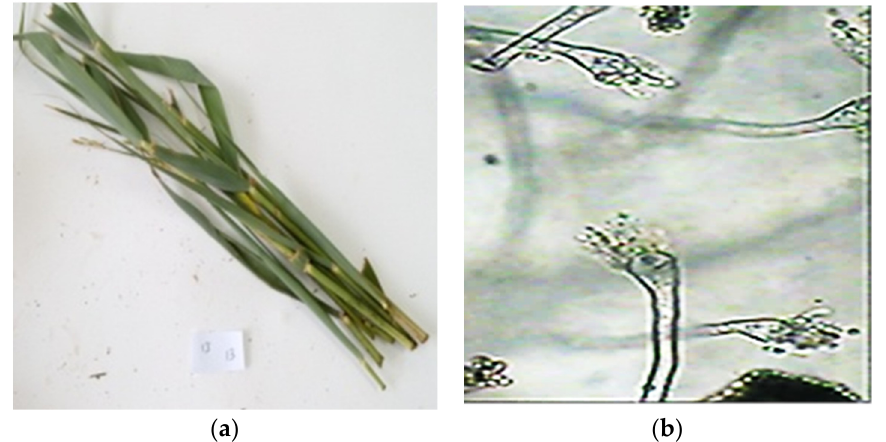
Figure 1. Representative photos of ( a ) P. australis leaves and ( b ) mycelium, conidiophores, and conidia as seen under the light microscope.